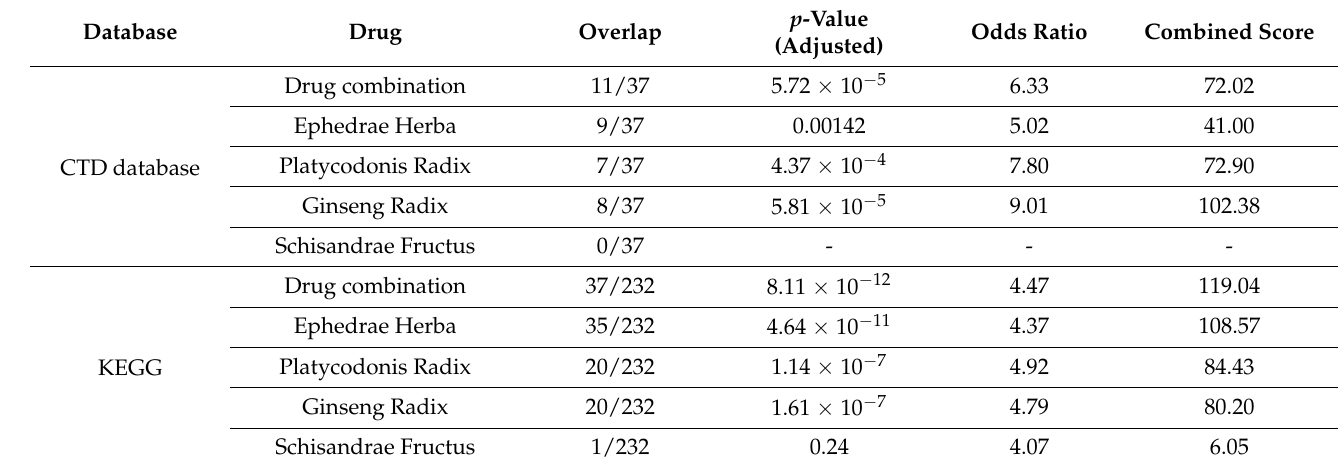
Table 3. Enrichment analysis of the impact of each drug on COVID-19-related